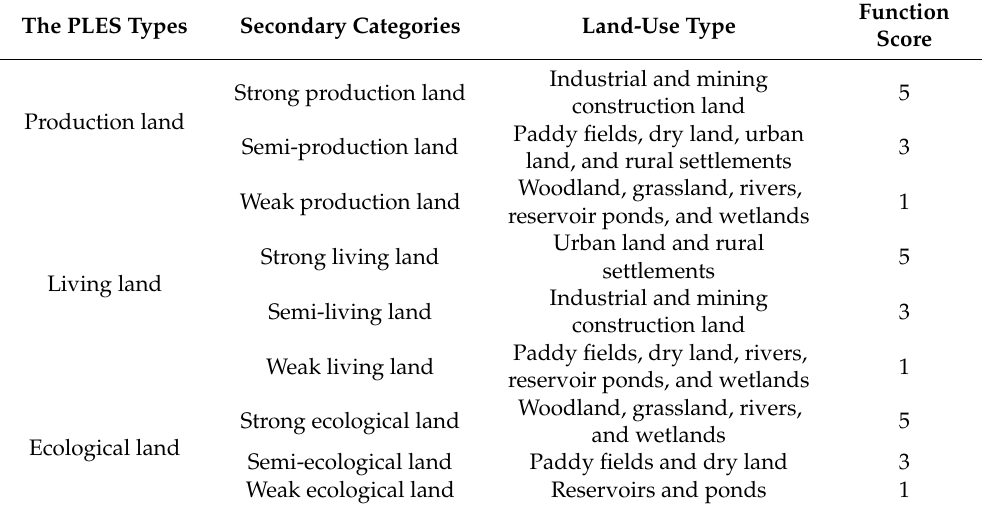
Table 1. Index system of